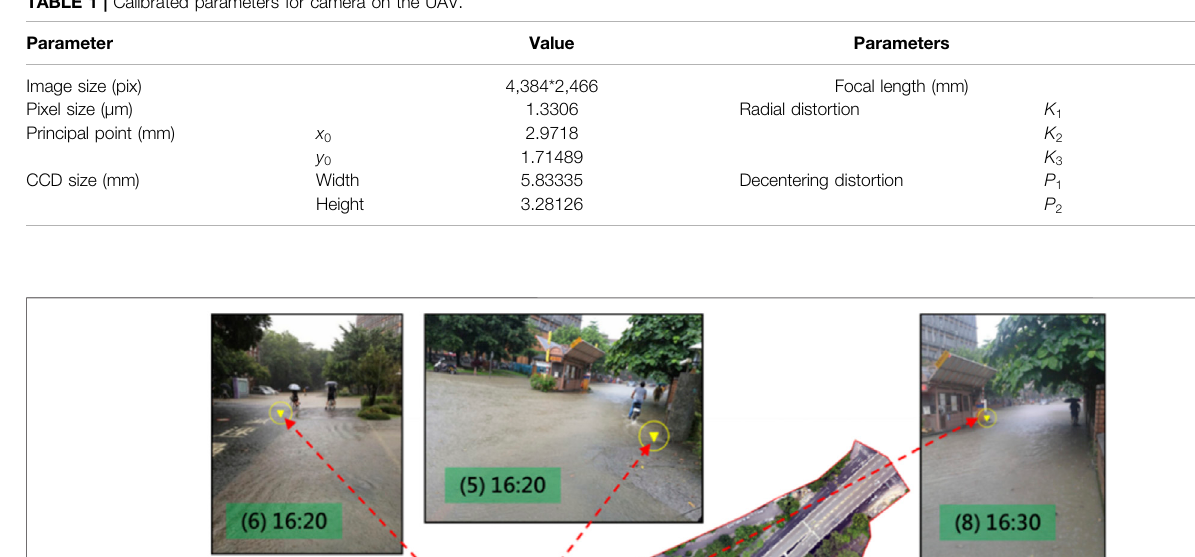
Frontiers in Earth Science |